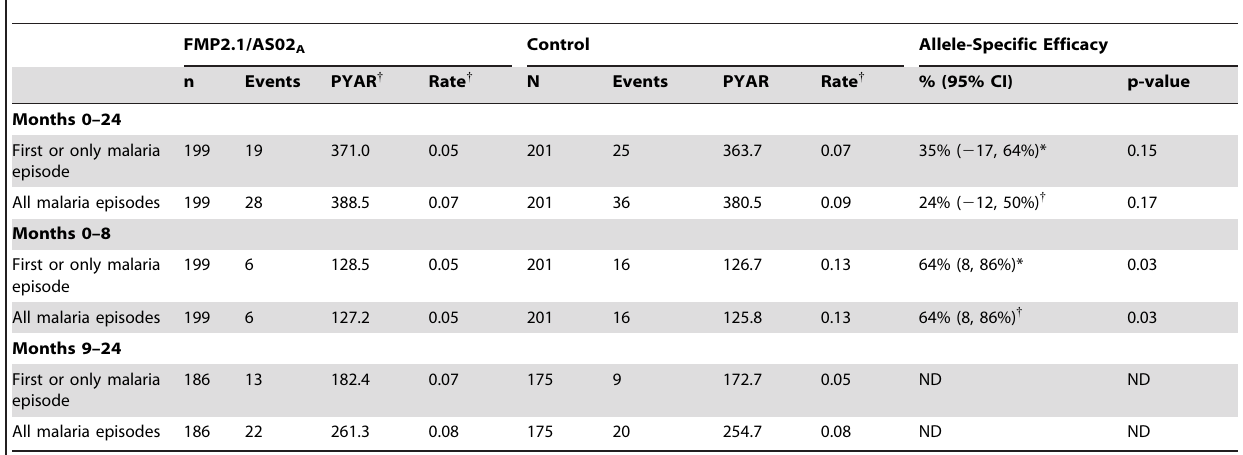
Table 4. Allele-specific vaccine efficacy against P. falciparum malaria, intention-to-treat